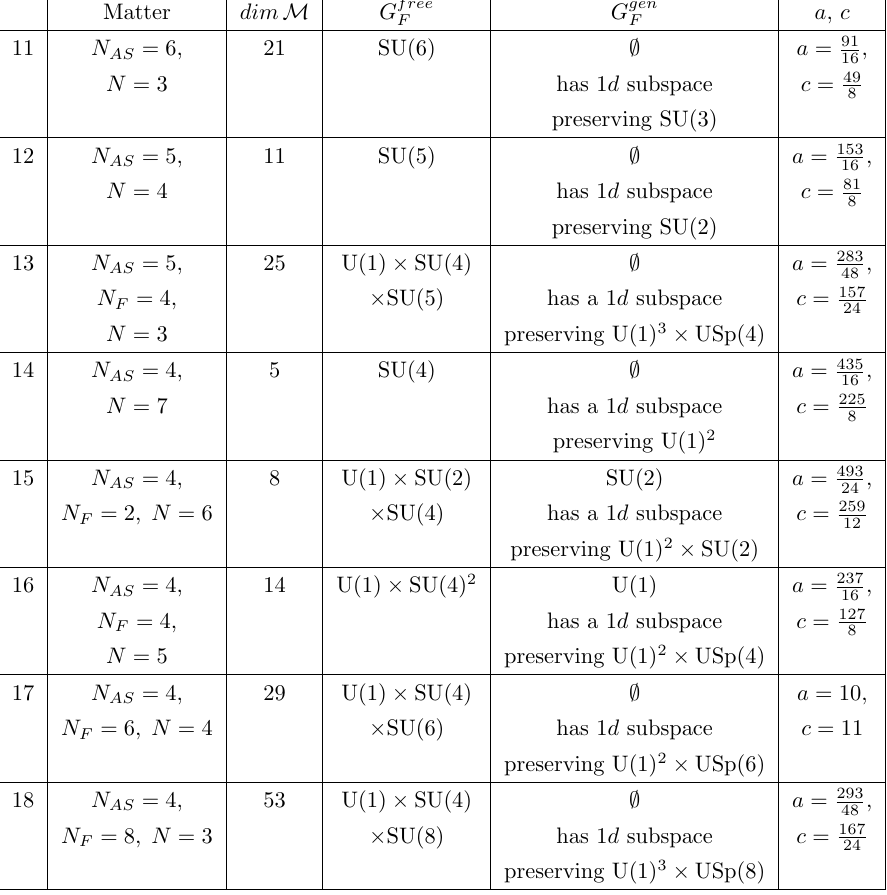
Table 14 . Cases involving a USp(2 N ) gauge group with only fundamental and antisymmetric chiral (cid:12)elds,